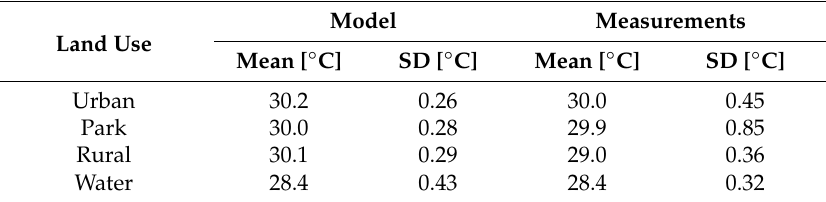
Table 1. Overview per land use class of the mean modelled and measured 2 m air temperatures, and their standard deviations (SD), for the afternoon (14–16 h Local Time) of 3 July 2015. Land Use